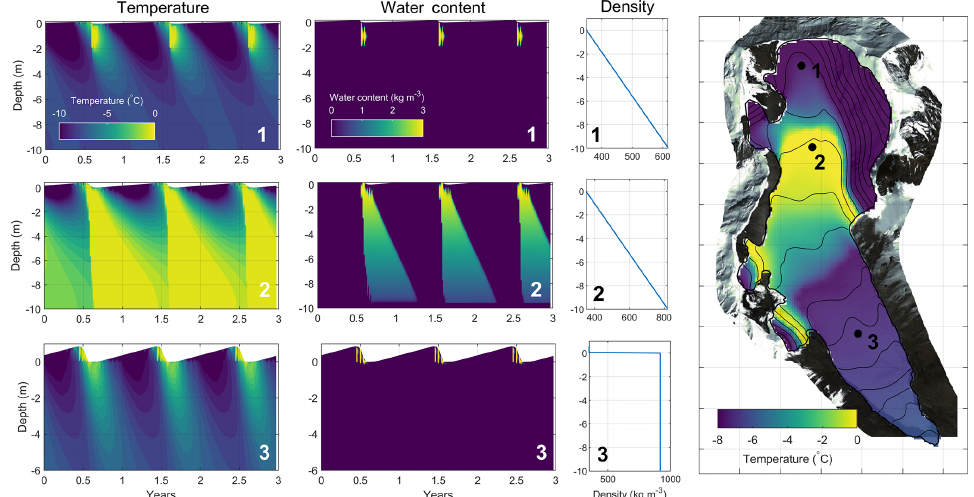
Figure 5. One-dimensional temperature, water content and density modelled in the first 10m of depth during 3 years and at three locations on the glacier. The one-dimensional model is forced by a reference temperature–precipitation annual cycle until reaching a stationary periodic response at 10m depth. Mean annual temperature at 10m depth is then used as an upper boundary condition for the thermo-mechanical model (mapped in the right panel).